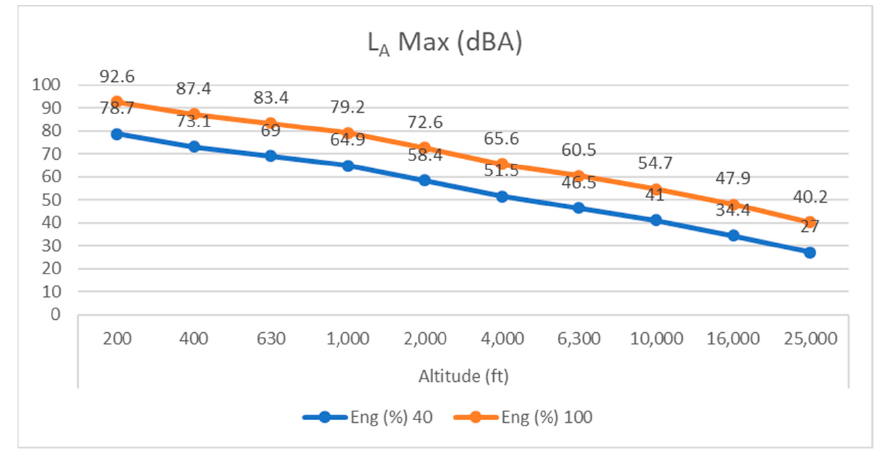
Figure 35. NPD curves, in terms of L AMax , for the DEP configuration.